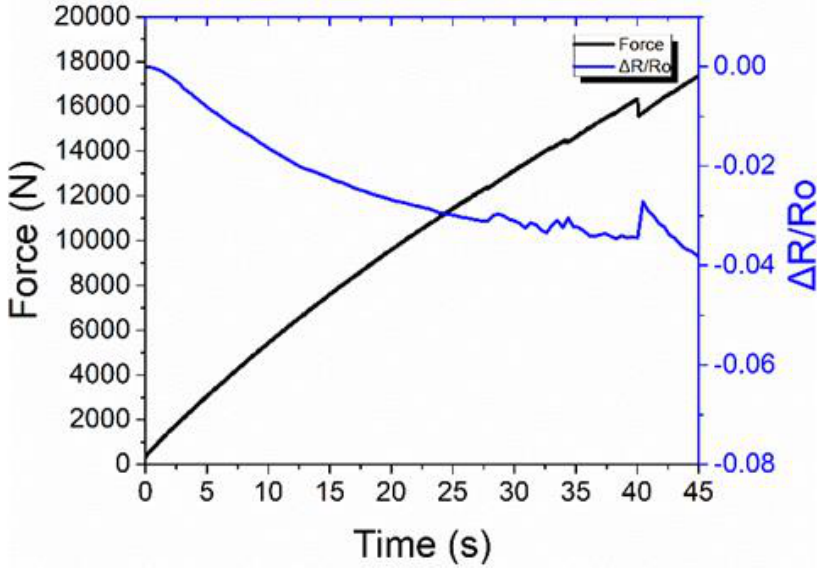
Figure 32. Representative lap strap test of the repaired 3R composite with ERCM